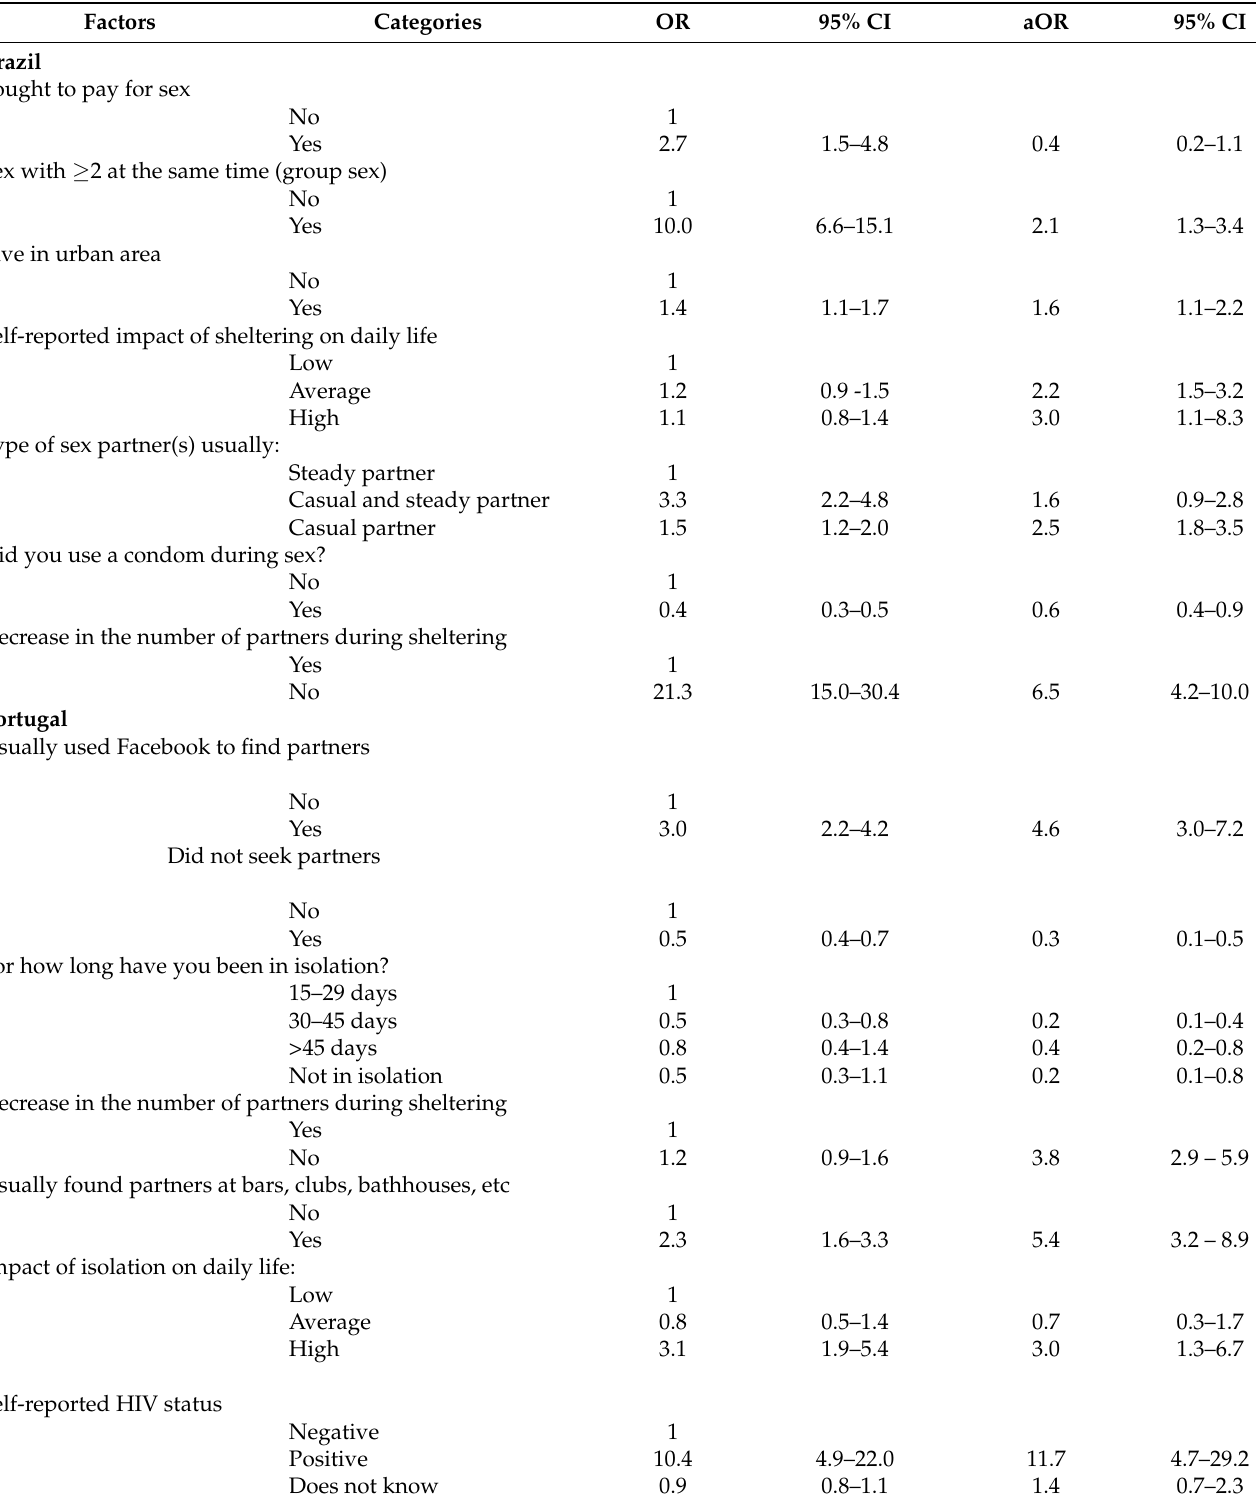
Table 2. Factors associated with having casual sex during the COVID-19 shelter in place period, men who have sex with men, Brazil and Portugal,